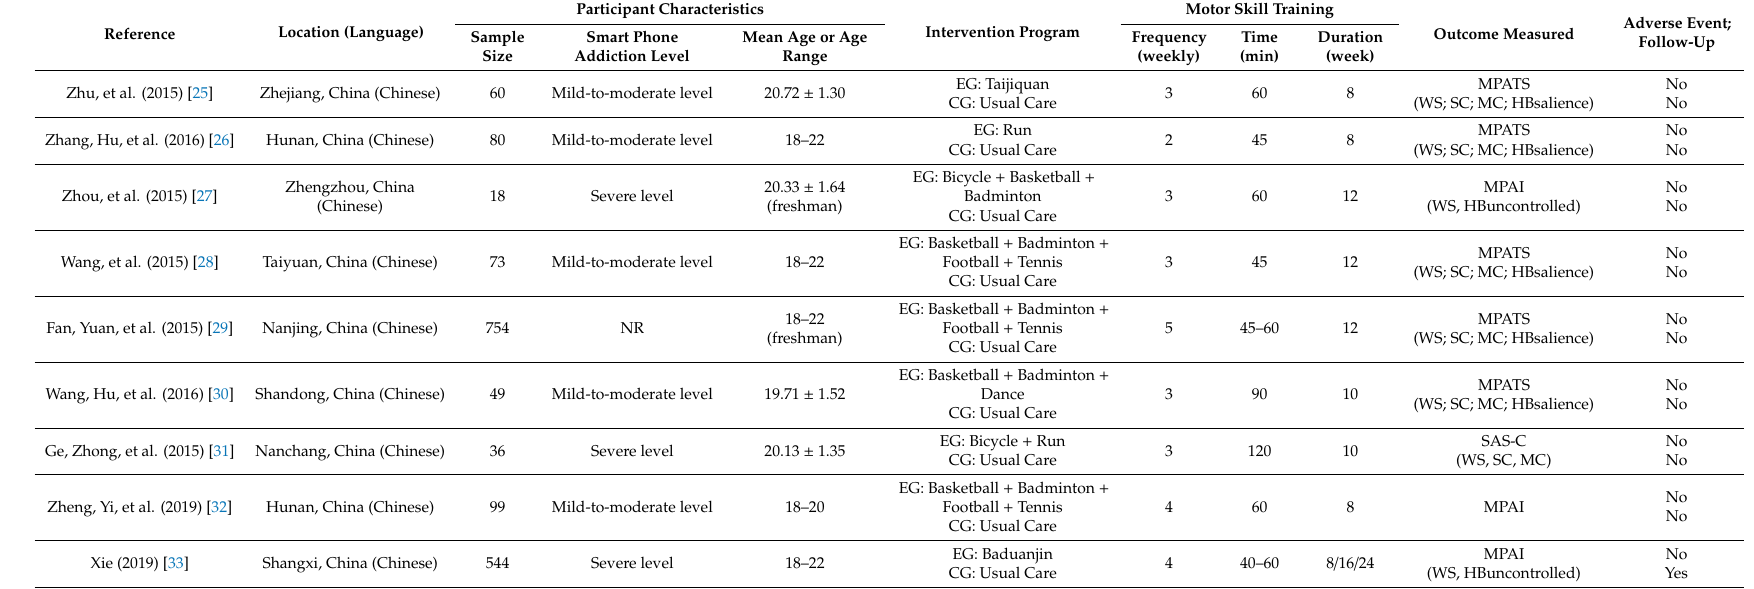
Table 1. Characteristics of included